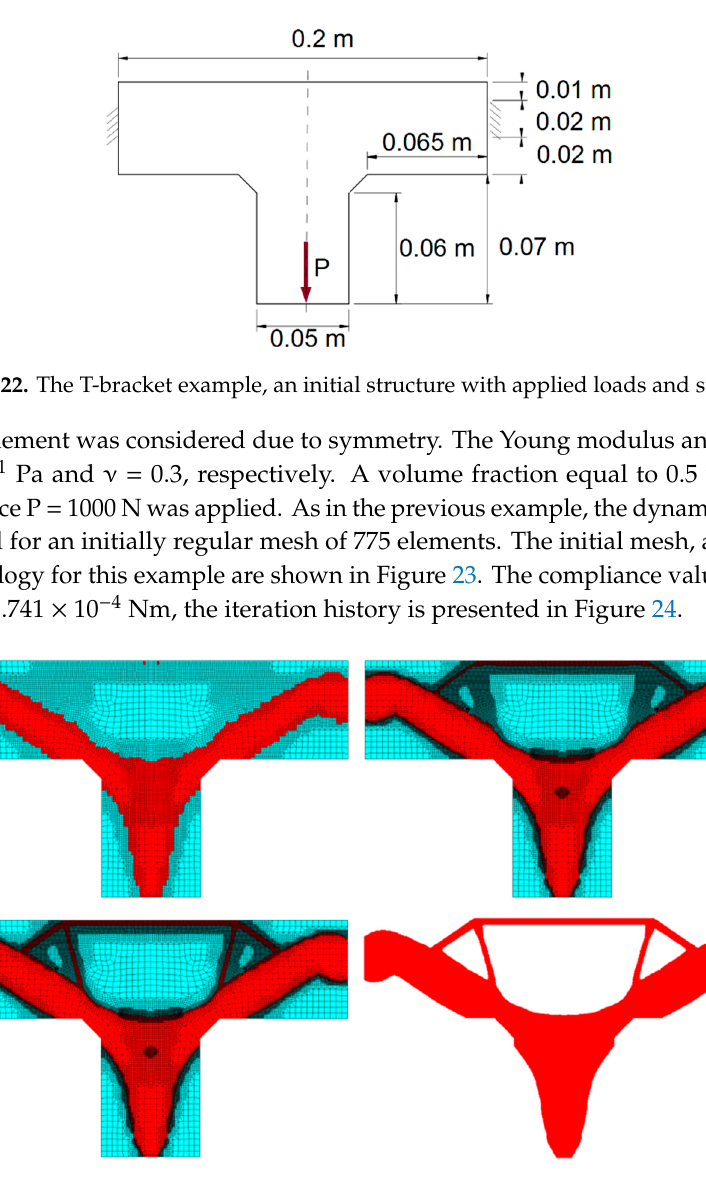
Figure 21. The final topology obtained using [37] with a small ( a ) and a large ( b ) filtering radius.